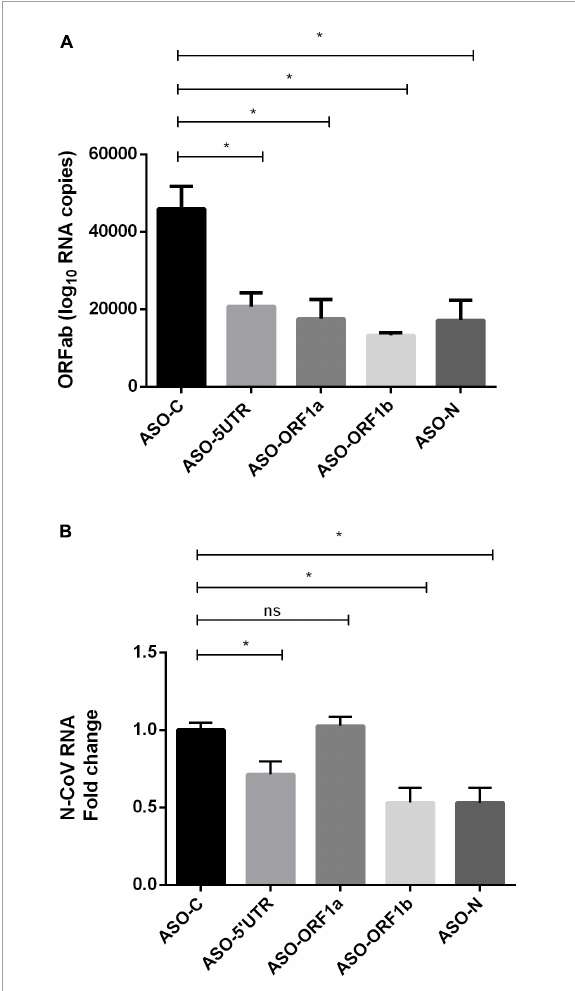
FIGURE2 Effects of transfection of ASO gapmers on ACE2-expressing HEK293T cells infected with SARS-CoV-2. Cells were transfected with ASO gapmers, followed by SARS-CoV-2 infection 5 h later. After 24 h post-transfection, cells and supernatants were collected. (A) Absolute quantification of the ORF1ab copy number by RT-qPCR. All four ASO gapmers exerted a significant effect on the ORF1ab RNA copy number in comparison with ASO-C ( p < 0.05). The reduction of the SARS-CoV-2 genome copy number reached 71% (–32,668 copies vs. ASO-C) for the treatment with ASO-ORF1b. Reduction was 55, 62, and 63% for ASO-5 (cid:48) UTR, ASO-ORF1a and ASO-N, respectively (* p < 0.05). (B) ASO efficiency measured as reduction in N-CoV expression by RT-qPCR in HEK-293T/ACE2 cells. ASO-ORF1b, ASO-N and ASO-5 (cid:48) UTR reduced the relative levels of the SARS-CoV-2 N transcript by 47, 47, and 29%, respectively ( N = 5; * p < 0.05), relative to ASO-C, while ASO-ORF1a displayed no effect. Relative fold-changes to ASO-C were computed after normalization to the housekeeping genes GUSB and